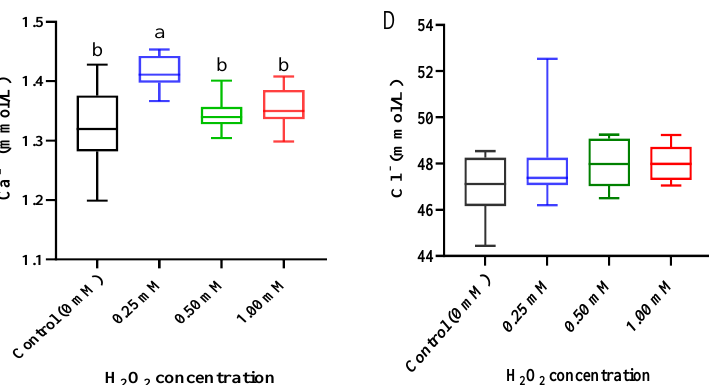
Figure 3. Ion concentration in plasma of Cyprinus carpio under H 2 O 2 exposure. ( A ) Sodium (Na + ); ( B ) potassium (K + ); ( C ) calcium (Ca 2+ ); ( D ) chlorine (Cl − ). Data are expressed as mean ± SE (n = 9). The different letters above each bar indicate a statistical significance among different concentrations of H 2 O 2 exposure ( p < 0.05).